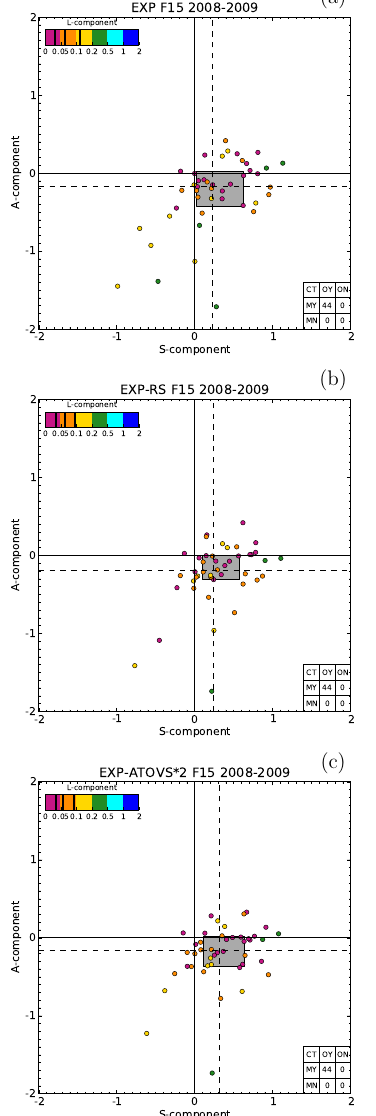
Fig. 10. Similarly to Fig. 9, SAL plots for the three experiments but now selecting only 2008 cases, (a) control (EXP), (b) EXP-RS and (c)